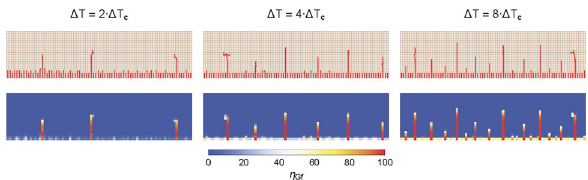
Fig. 32 Thermal shock problem for different load intensities. Top: elements with initiated cracks. Bottom: dissipated percentage of fracture